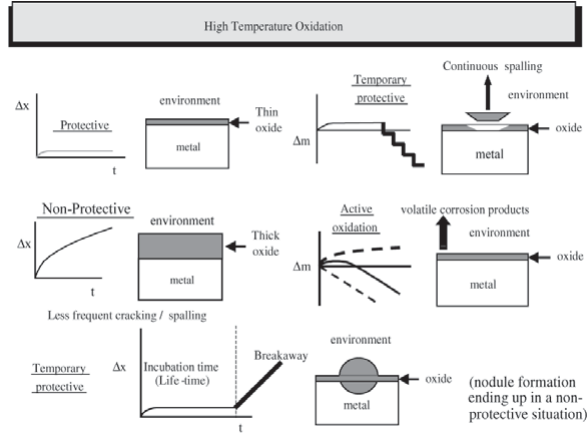
Figure 2. Three steps of oxide scale formation starting with small nodules until thick continuous oxide layer formation for P91 at 650 °C. Figure 3. Schematic of the different types of oxidation behaviour.